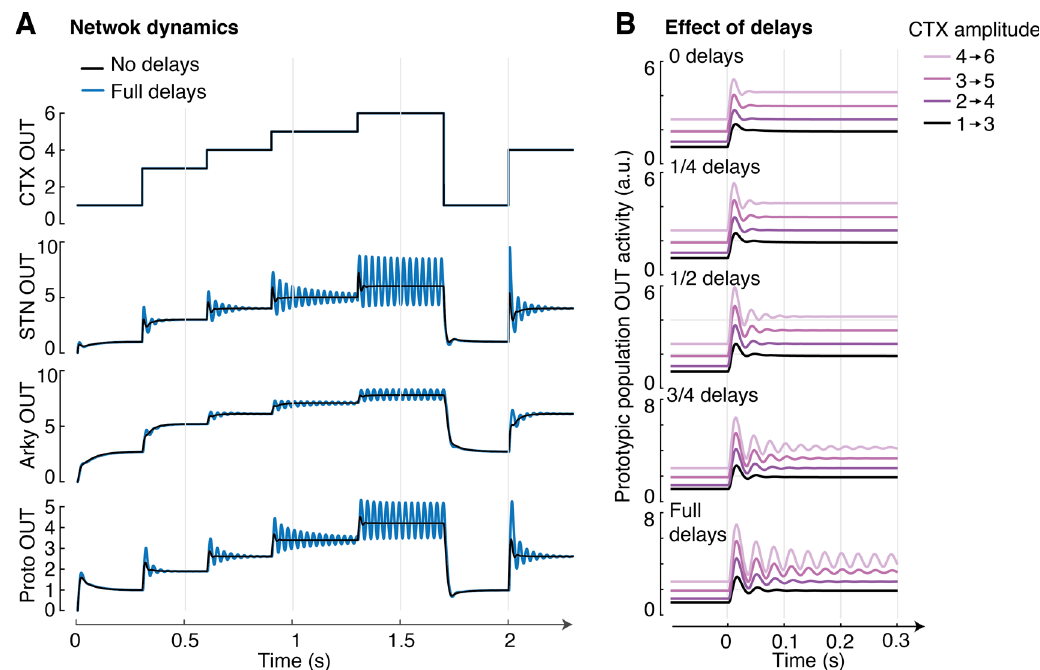
Fig 7. Dynamical behaviour of STN-GPe network. (A) Output responses of STN, Arkypallidal and Prototypic populations for a sequence of cortical ( CTX ) input steps ranging from 1 to 6 (a.u.). The output from arkypallidal neurons is taken as w AP < ARK i ( t ) > i , while the output from prototypic neurons was taken as traces correspond to the behaviour of the system without and with delays respectively. (B) Evaluation of the effect of delays in the system in response to varying cortical input. As delays increase (and delay values approach those reported in literature), the cortical input for which the system becomes unstable